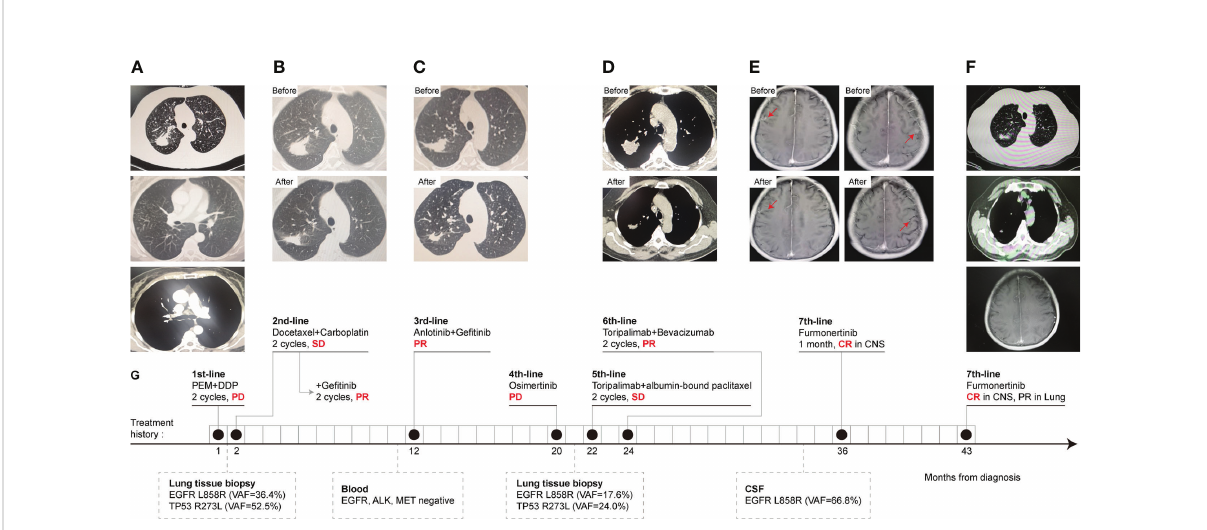
FIGURE 1 CT scans, treatment history, and gene mutation of case 1 at different clinical time points as shown. CT scans results. (A) Chest CT scans of right lung adenocarcinoma and lymph nodes before fi rst-line treatment. (B) PR was observed after ge fi tinib was added to the combined chemotherapy, second-line treatment. (C) The change of lung lesion before and after third-line treatment, anlotinib plus ge fi tinib. (D) CT scans before and after two cycles of terriprizumab plus bevacizumab, sixth-line treatment. (E) MRI of the brain. CR of LM was obtained after 1 month of furmonertinib, seventh-line treatment. (F) The lung and CNS lesions were kept stable until recent follow-up in April 2022. (G) The timeline of Case 1 treatment history, follow-up diagnostic and gene test results. Numbers indicate the time from the diagnosis of NSCLC. CR, complete response; PR, partial response; SD, stable disease, PD, progressive disease; CSF, cerebrospinal fl uid; CNS, central nervous system; VAF, variant allele